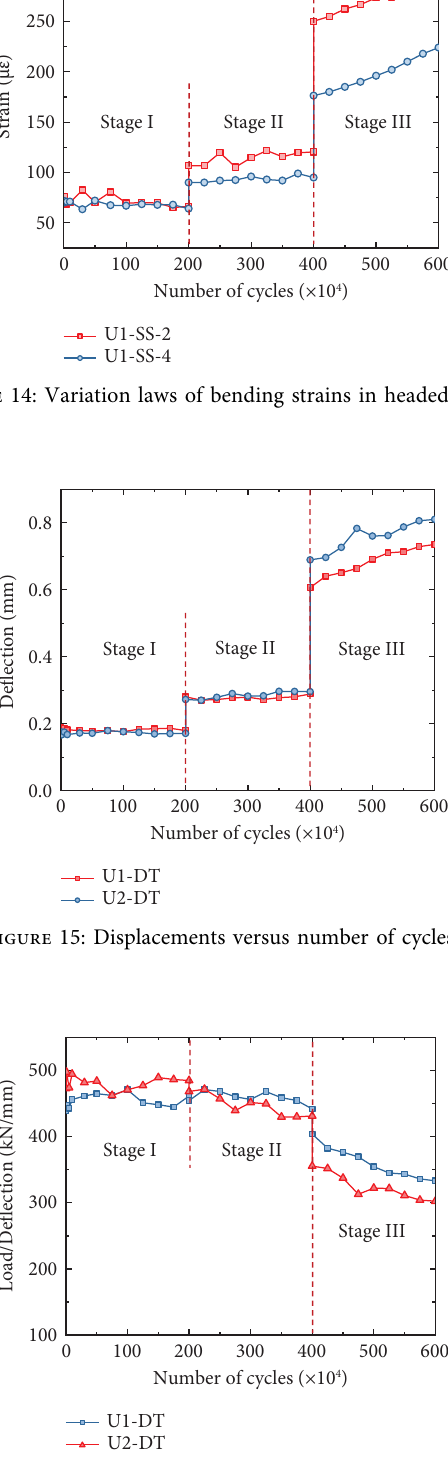
Figure 16: Variation laws of local stifness at loading point.